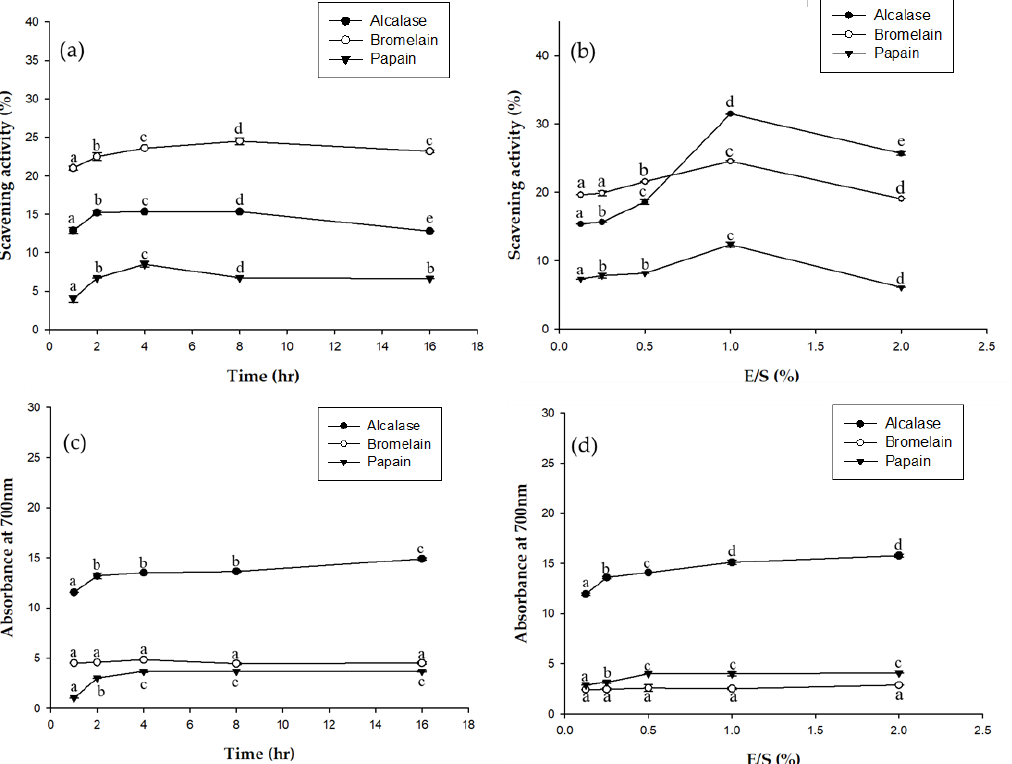
Figure 2. Antioxidant effect of the three EPHs (alcalase, bromelain, and papain) using three 178 antioxidant assays: ( a ) Antioxidant effect at different times based on DPPH free radical scavenging 179 assay; ( b ) Antioxidant effect at different enzyme concentrations based on DPPH free radical 180 scavenging assay; ( c ) Antioxidant effect at different times based on reducing power assay; ( d ) 181 Antioxidant effect at different enzyme concentrations based on reducing power assay; ( e ) 182 Antioxidant effect at different time based on ABTS total antioxidant capacity; ( f ) Antioxidant effect at 183 different enzyme concentrations based on ABTS total antioxidant capacity. Means in the same form 184 with various characters denote significant differences ( p ˂ 0.05). Data are expressed as mean±SD from 185 triplicate determinations. 186